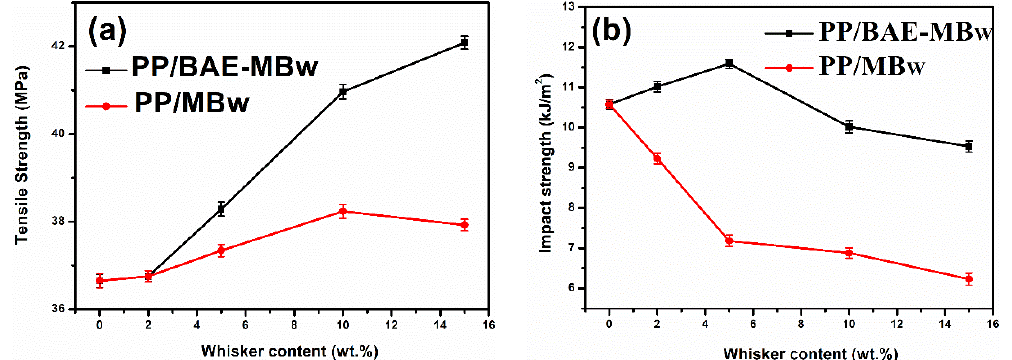
Figure 1. The variation of ( a ) tensile strength at yield and ( b ) impact strength with whisker contents for polypropylene (PP) composites.